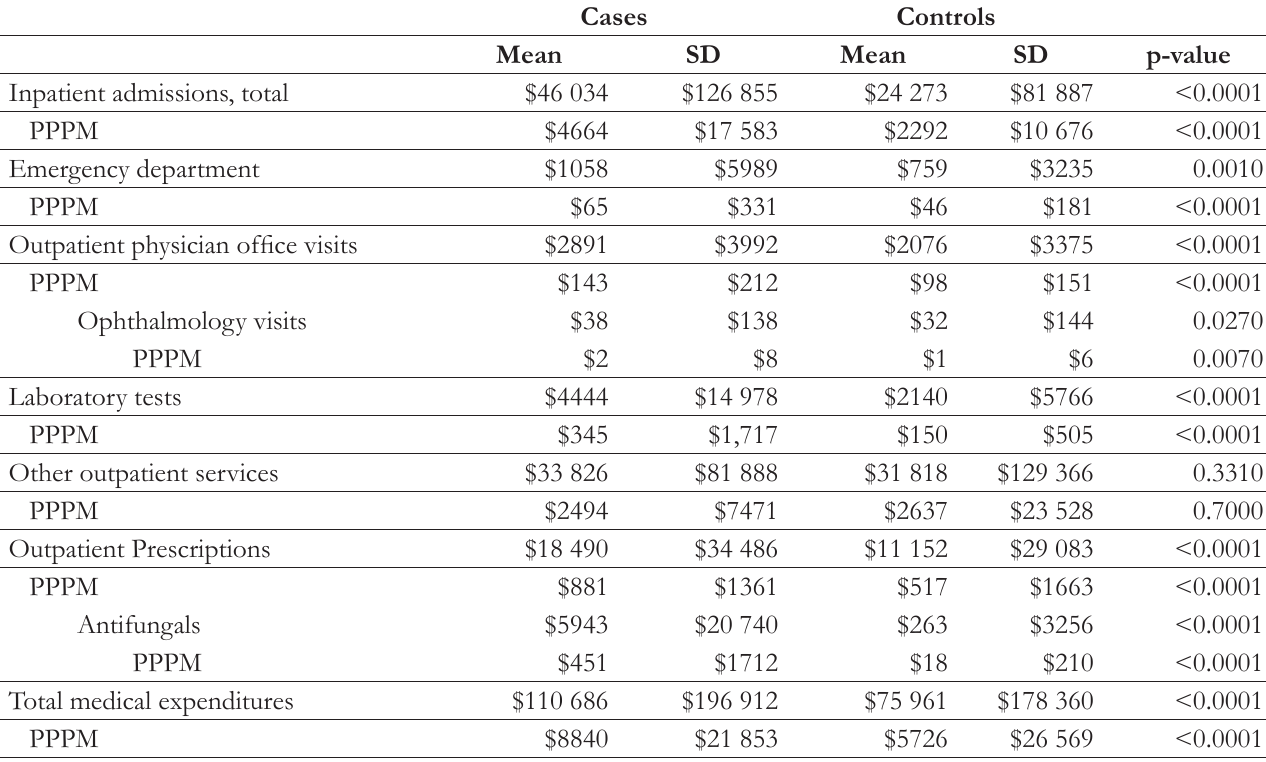
Table 5. Unadjusted Healthcare Expenditures of Aspergillosis Cases and Matched Controls